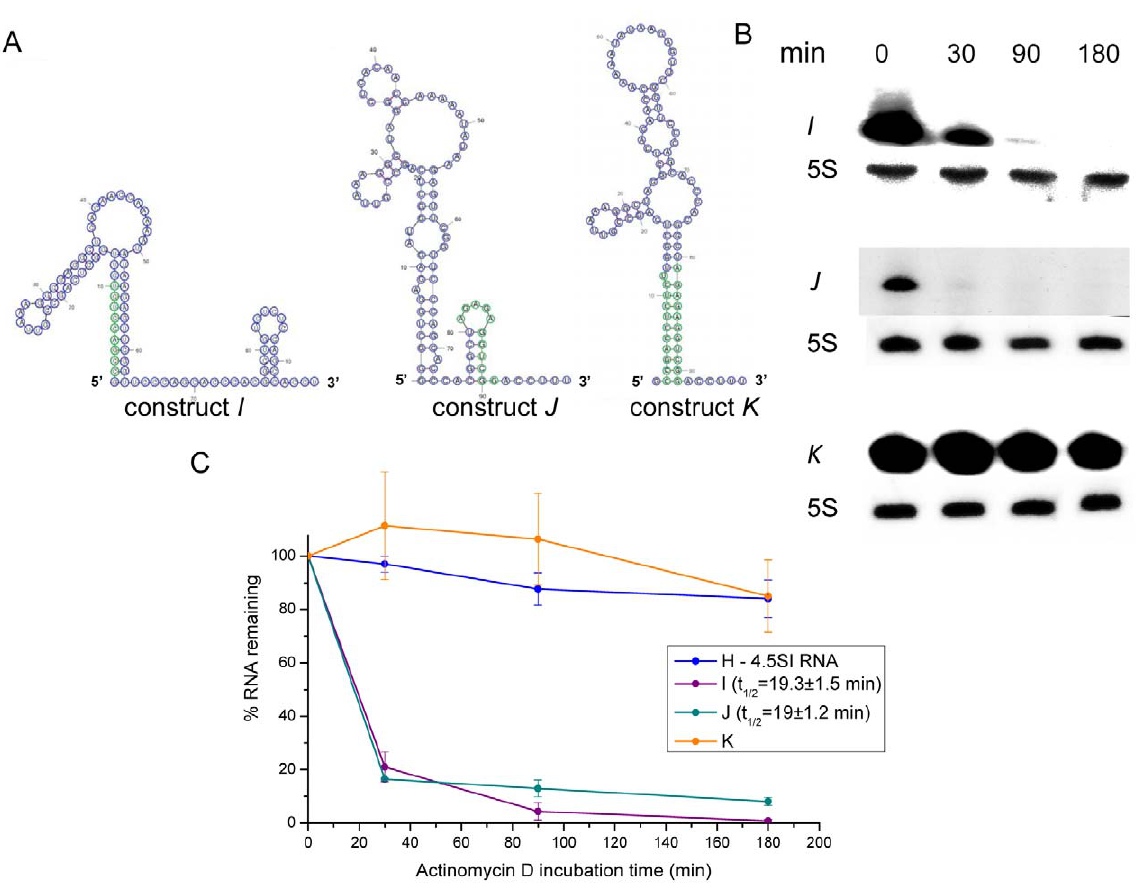
Figure 6. The impact of the end stem on the 4.5SI RNA lifetime. ( A ) Predicted secondary structures of 4.5SI-derived RNAs. (See the nucleotide sequences of the corresponding constructs in Fig. 3). Designations are the same as in Fig. 5. ( B ) Detection of RNA transcribed from the constructs I , J , and K in HeLa cells treated with actinomycin D. 5S rRNA was used as a loading control. ( C ) Decay kinetics of RNA transcribed from constructs I , J , K , and H (original 4.5SI RNA). Each graph is based on data from three transfection experiments (error bars, s.d.). Average half-lives with standard deviations only for short-living RNAs ( I and J ) are presented.